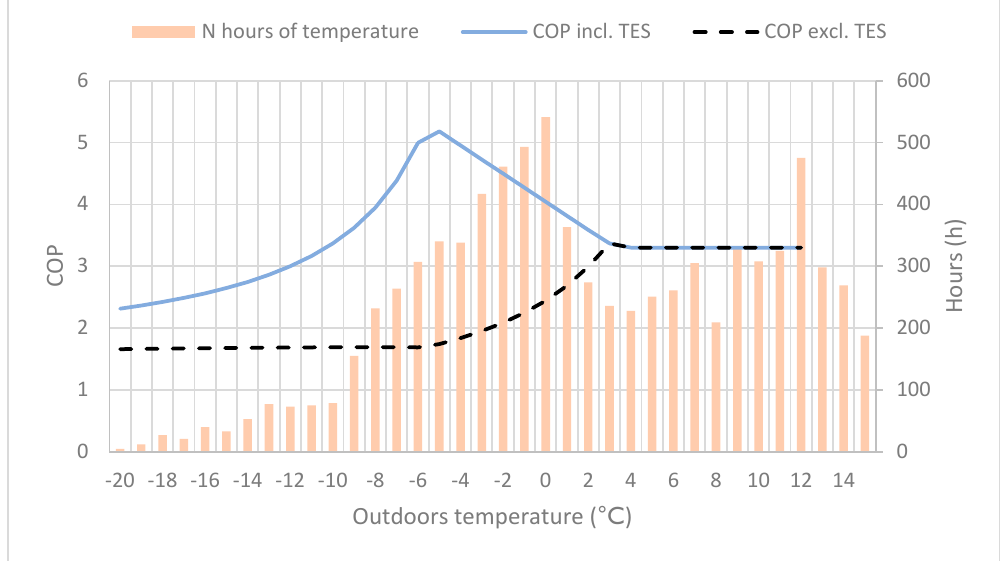
Figure 4. The coefficient of performance (COP) with and without the thermal energy storage (TES) Figure 4. The coe ffi cient of performance (COP) with and without the thermal energy storage (TES) reactor, and the number of hours for varying outdoor temperature. reactor, and the number of hours for varying outdoor